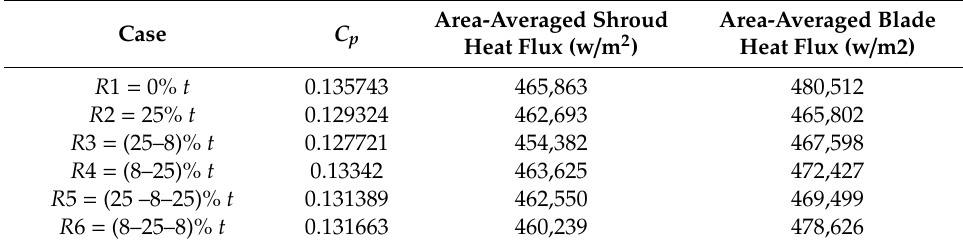
Table 4. Loss Coe ffi cient and area-averaged Shroud / Blade Heat